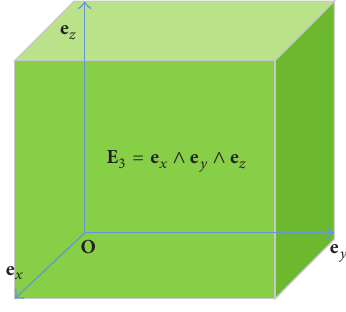
Figure 2: The geometry of